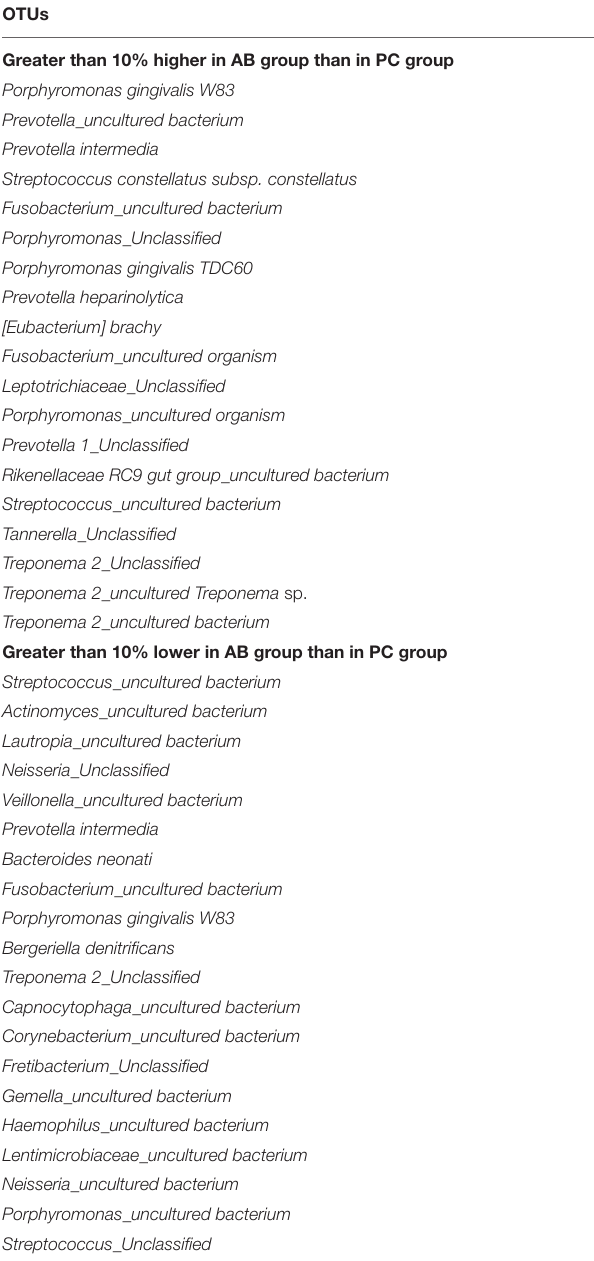
TABLE 2 | The Dominant OTUs in AB group compared to PC group at patient level. OTUs Patients (Radio) Greater than 10% higher in AB group than in PC